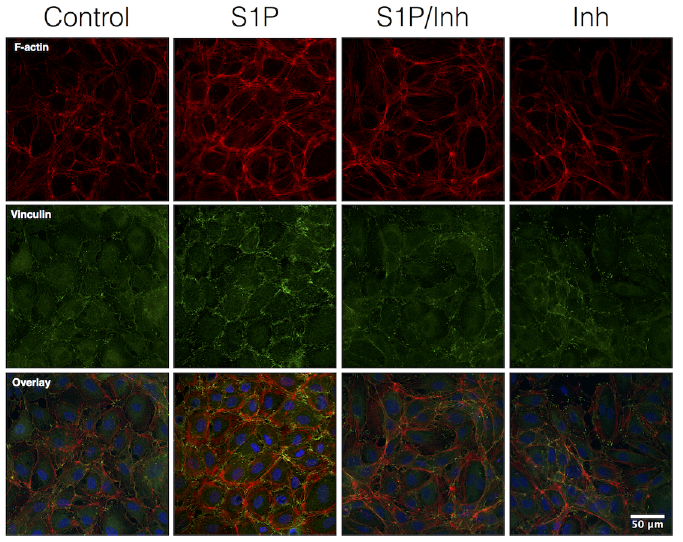
cells (10 min after the addition of S1P). This was inhibited after pretreatment with combined Rhosin and Y-16 (Inh; 5 μ M each, 30 min). The inhibitors alone had no impact. All images are representative of 3 separate